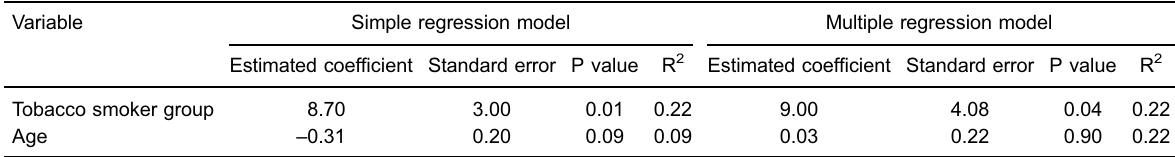
Table 3. Multiple linear regression analysis of the effect of group and age on arterial oxygen tension (PaO 2 ).